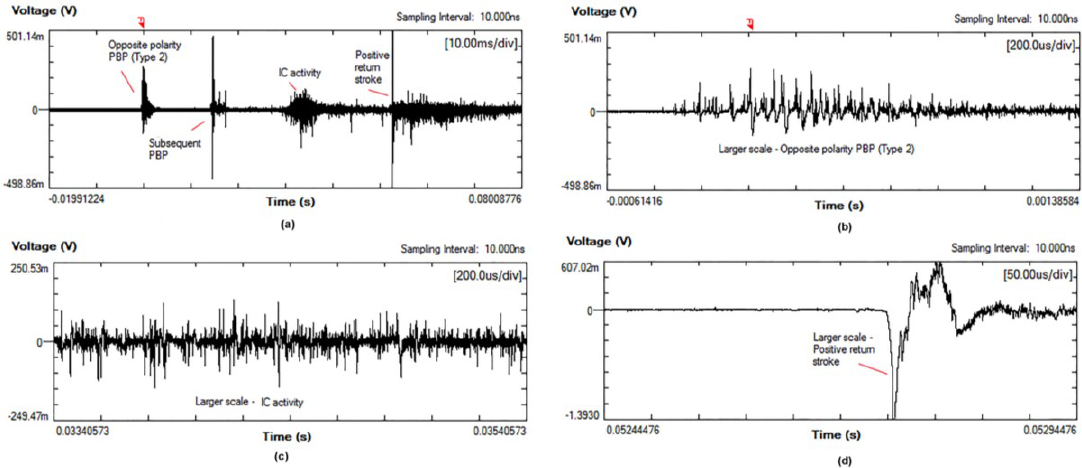
Figure 4. ( a ) Type 2 PBP—Opposite polarity PBP; ( b ) Zoom in of PBP train having opposite polarity pulses from the positive RS; ( c ) Zoom in of IC activity; ( d ) Zoom in of positive RS.